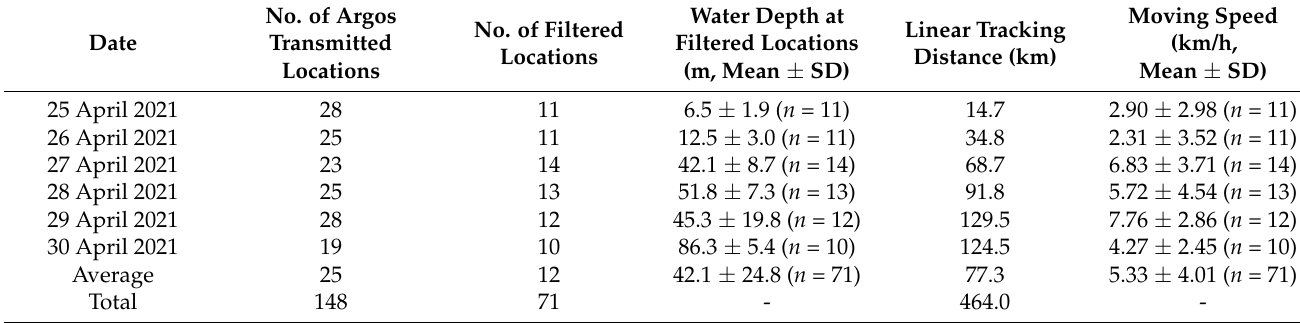
Figure 3. ( A , B ) Right and left lateral side of a satellite-tagged Bryde’s whale (BE-BG-ST01) in the Beibu Gulf on 25 April 2021; ( C ) left side of BE-BG-ST01 on 21 April 2021; ( D ) daily tracking route and ( E ) moving speed of BE-BG-ST01 based on Argos-satellite locations in the Beibu Gulf from 25 to 30 April 2021. Table 2. Information on a satellite-tracked Bryde’s whale from 25 April to 30 April